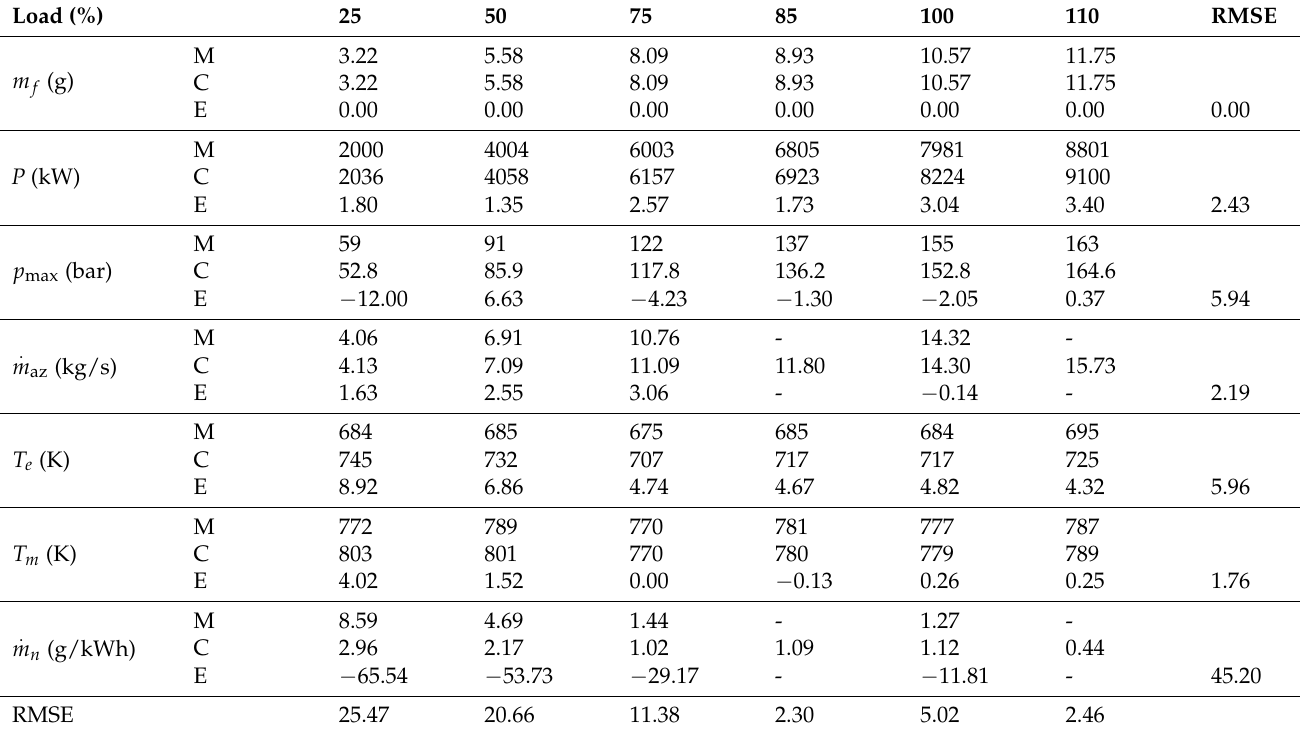
Table 9. The performance of the dual-fuel engine running in gas fuel mode with the WA